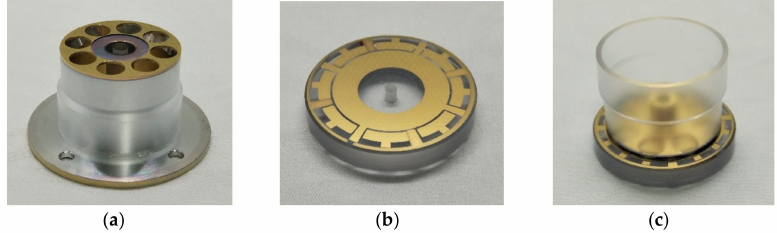
Figure 1. The structure of the fused silica cylindrical resonator: ( a ) The cylindrical resonator with a film coated on the bottom; ( b ) Plate electrode; and, ( c ) The integration of the cylindrical resonator and the plate